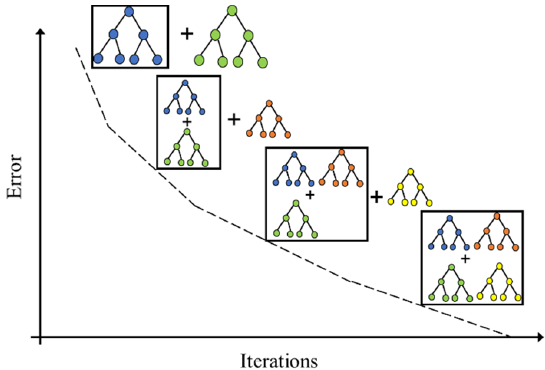
Figure 6. Schematic procedures of the Gradient Boosting classifier.